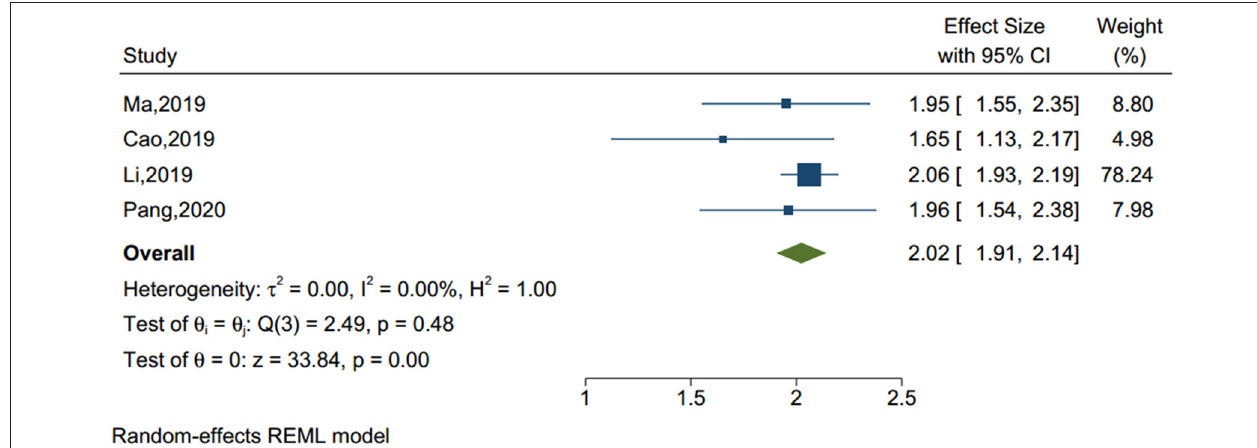
FIGURE 6 | Forest plot of studies including problematic internet use factor.